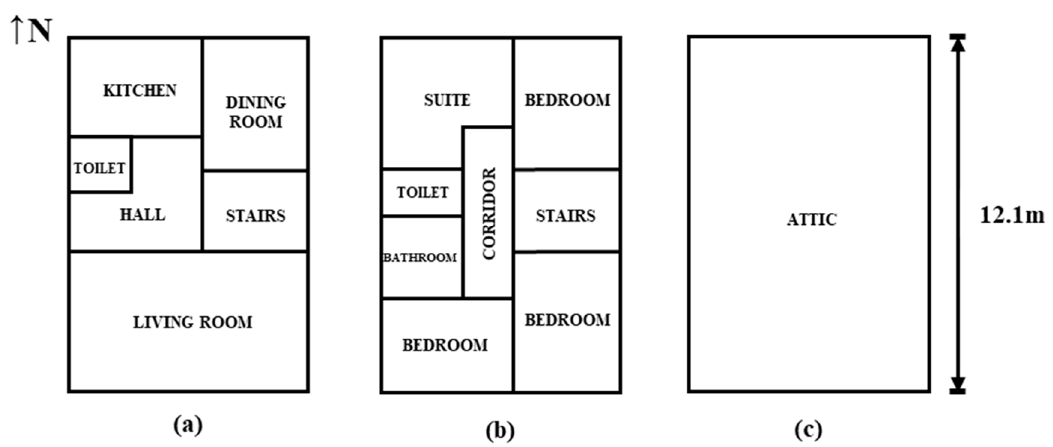
Figure 1. Plans of the building: (a) ground floor, (b) first floor, and (c) attic.